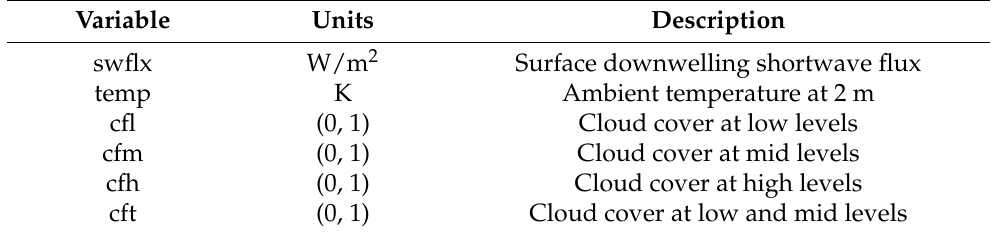
Table 4. PV forecasting model NWP input